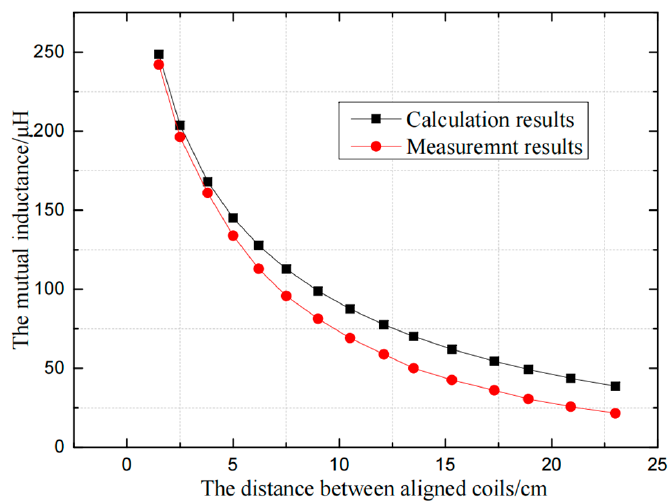
Figure 21. Theoretical calculation and practical comparison of coil mutual inductance.